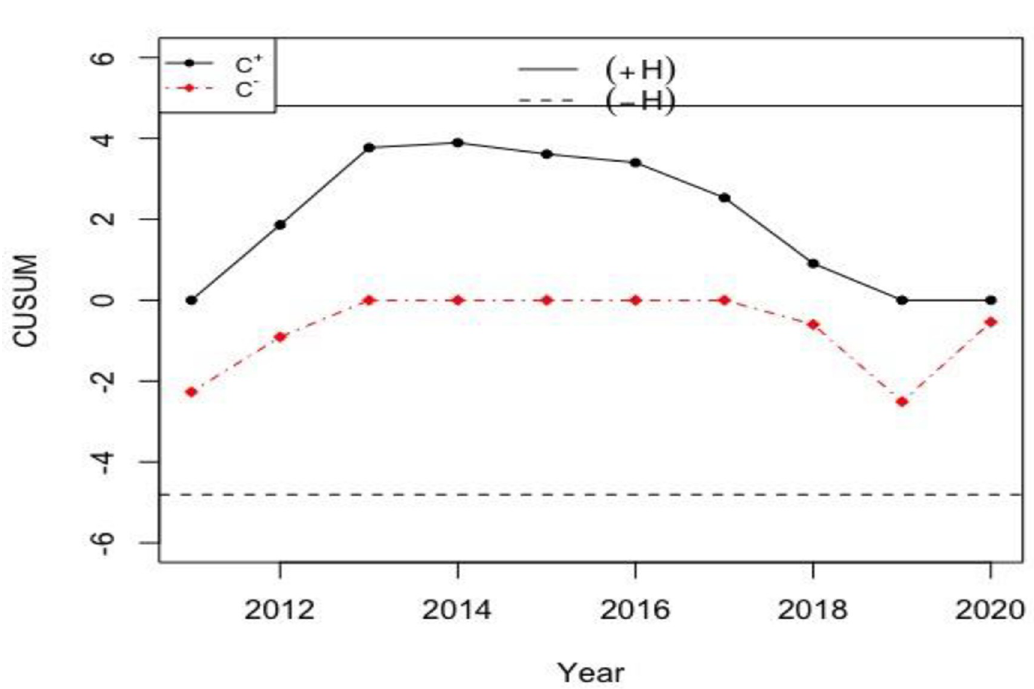
Fig 4. Real-life data from PSO petroleum company’s stock price for the classical CUSUM � X chart with h = 4.804 and k = 0.5.